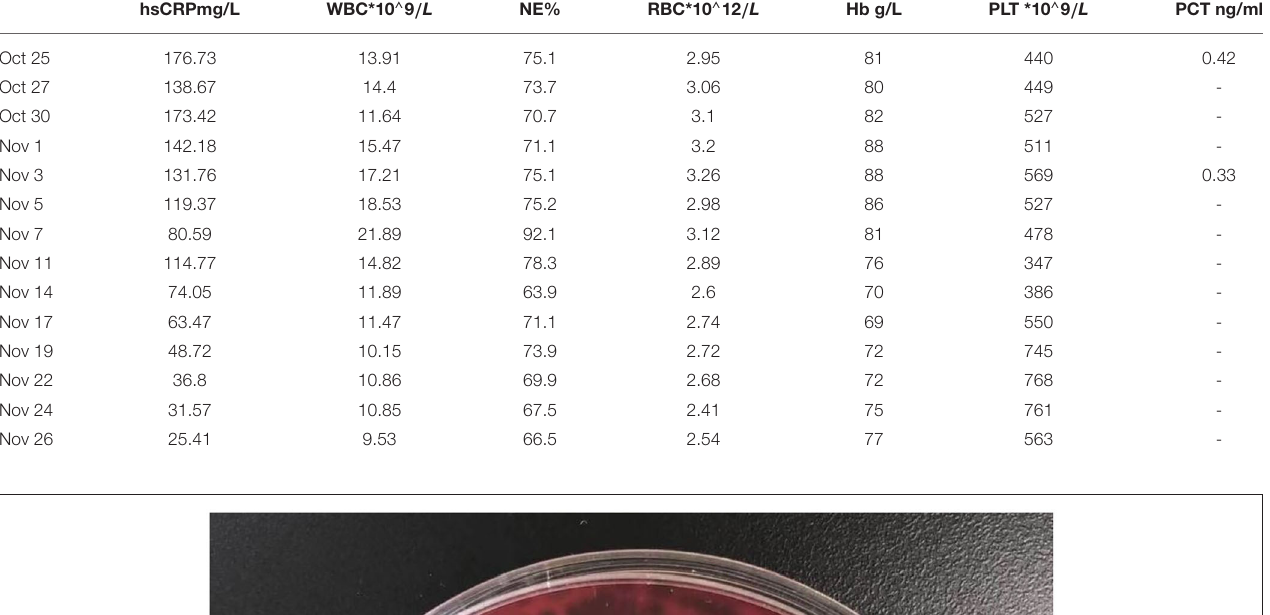
TABLE 3 | Routine blood test, hsCRP and procalcitonin (PCT).